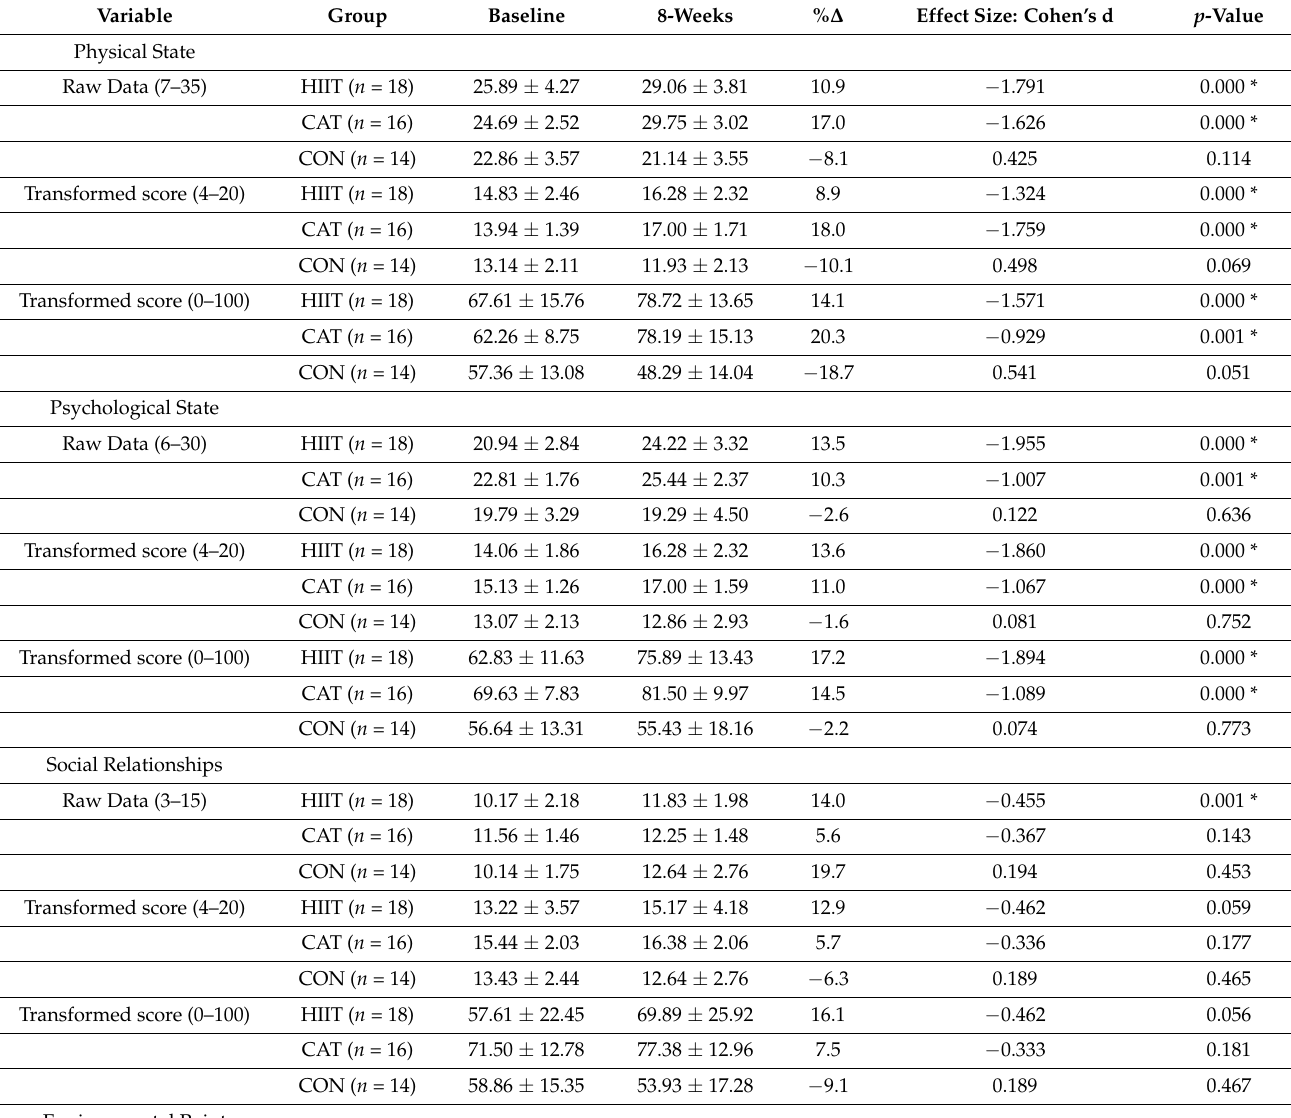
Table 1. Intra-group comparisons of health-related quality of life variables (raw data and transformed scores): physical, psychological, social relationships, and environment in college-aged smokers following 8 weeks of high-intensity interval training (HIIT), continuous aerobic training (CAT) and a control group